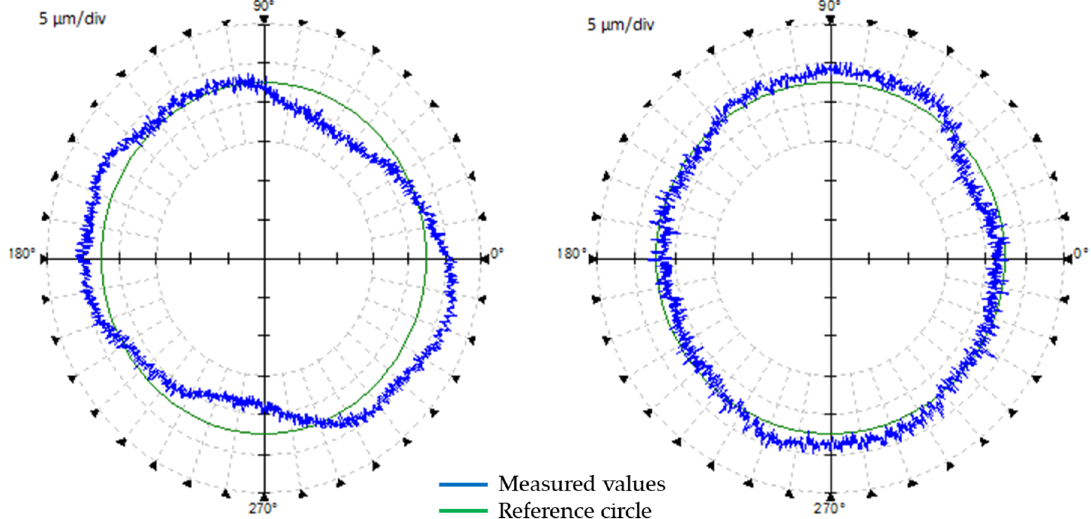
Figure 12. Evaluation of total roundness (RONt), 300 mm diameter.